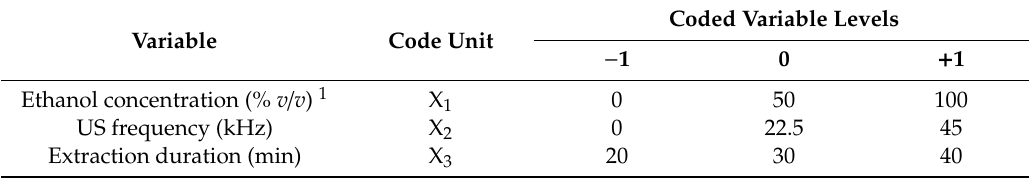
Table 1. Identity, code unit, coded levels, and actual experimental values of each variable used for USAE of TPC from almond oil